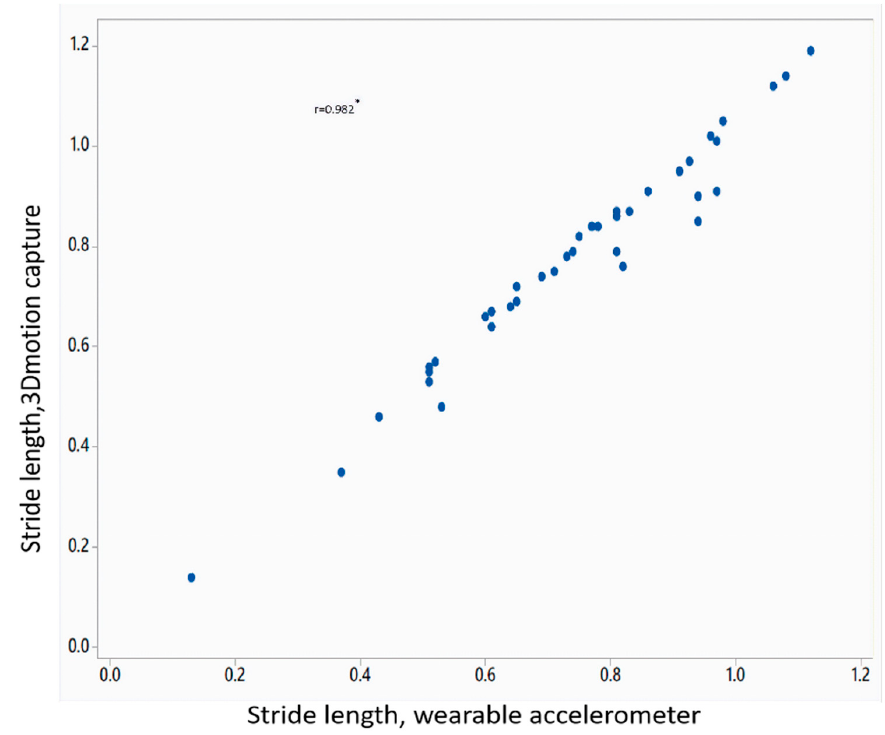
Figure 8. Correlation plot of stride length estimated from wearable accelerometer-based approach and 3D motion capture system (* p < 0.01).